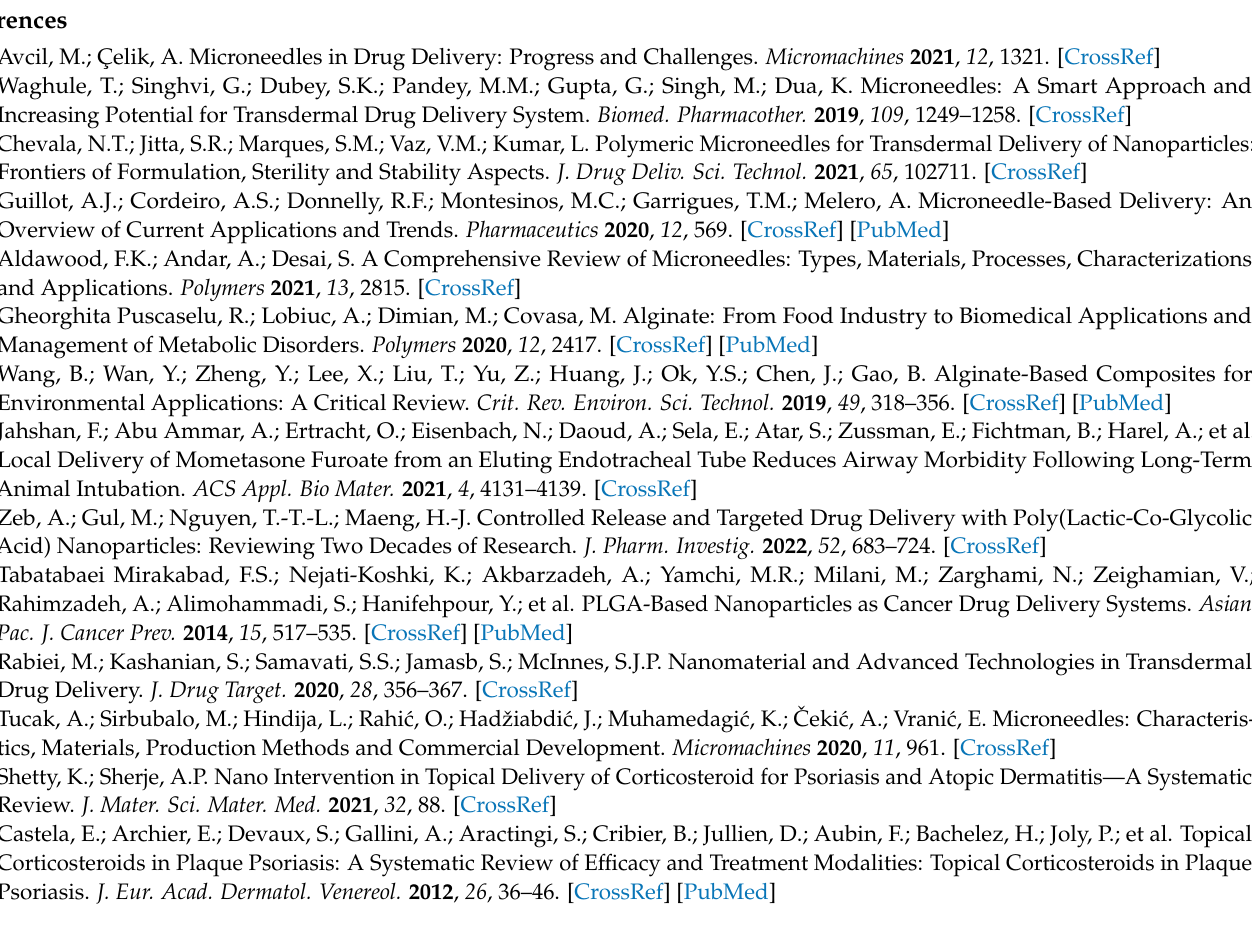
at 242 nm. Figure S3: FTIR spectrum of Solutol HS 15. Figure S4: Images of MNs loaded with blank PLGA NPs (A) before and (C) after the insertion test. (B) Representative microscopic image of holes created on the first parafilm